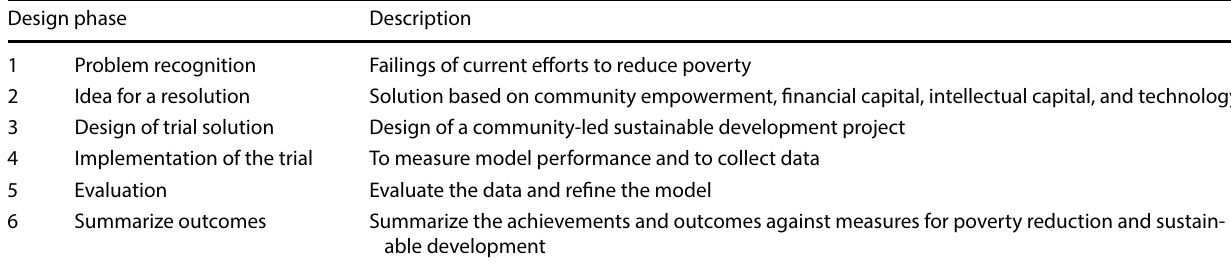
Table 5 DSRM for Sustainable